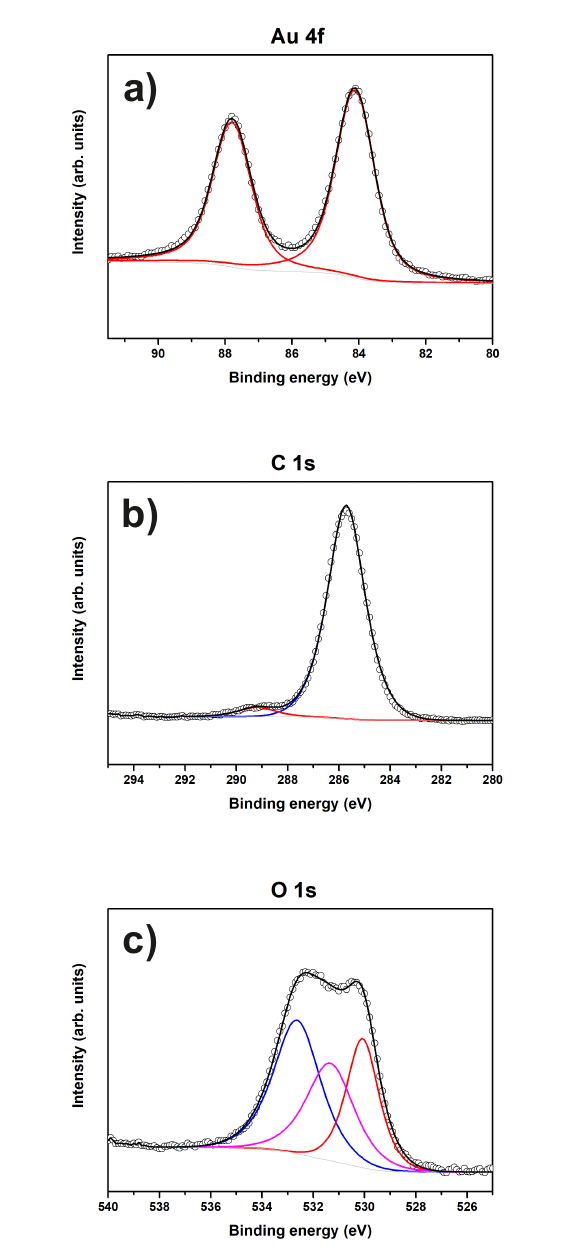
Figure 2. XP spectra of sample “Au”. The peaks of ( a ) Au 4f; ( b ) C 1s; and ( c ) O 1s and corresponding fits are